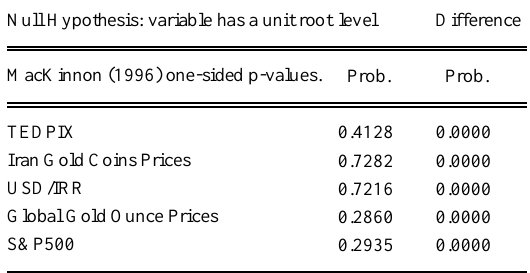
Table 2: The Augmented Dickey-Fuller Test Results Augmented Dickey-Fuller test statistic